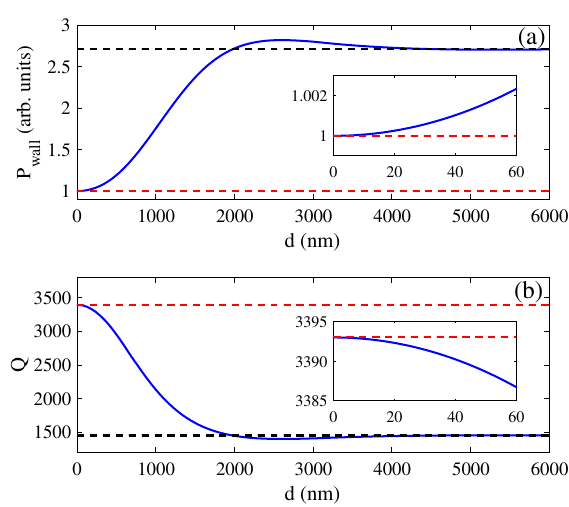
FIG. 19. Metallic wall loss (a, normalized to that of copper without coating) and quality factor (b) of the uniform section in the presented dielectric-loaded power extractor as a function of the chromium coating thickness (solid blue lines). The values using bulk copper ( d ¼ 0 , red dashed lines) and bulk chromium ( d ¼ þ ∞ , black dashed lines) are also plotted for comparison. Inset: magnified view at small coating